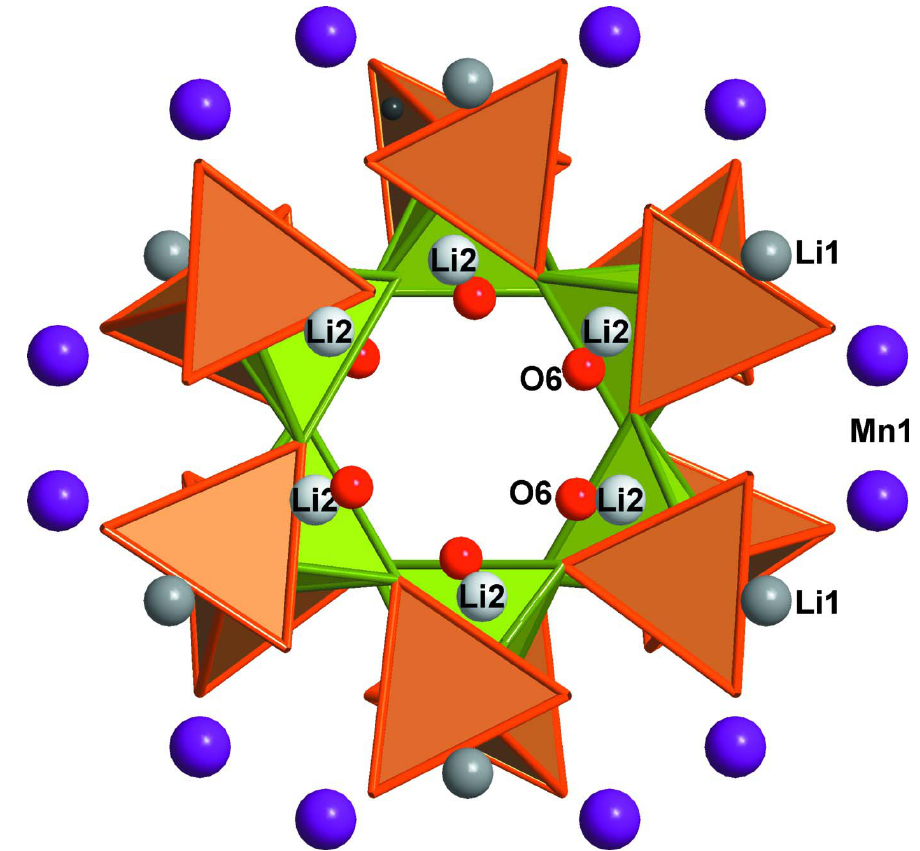
Figure 2 Section of LiMn(H